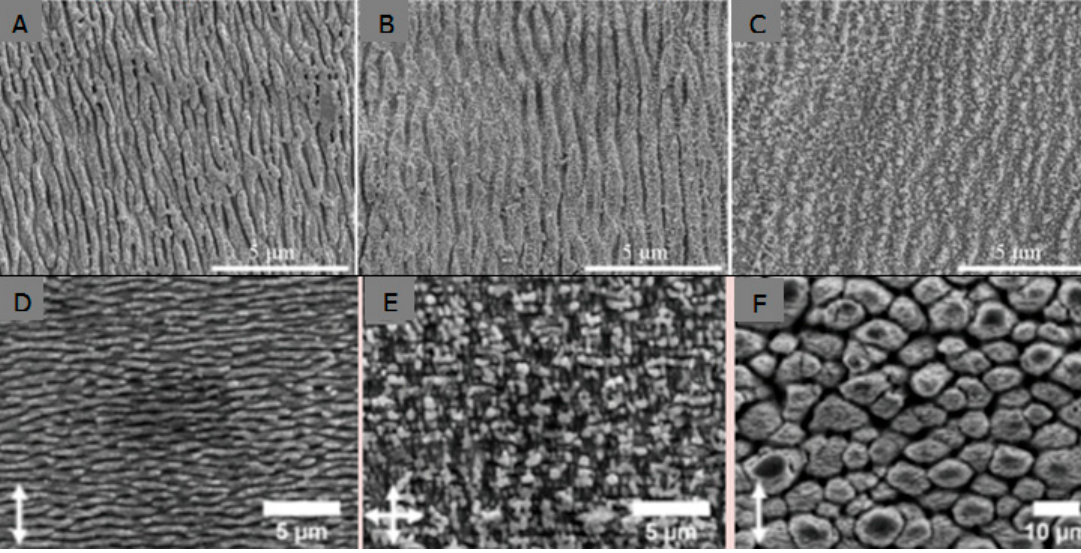
Figure 10. SEM micrographs of laser-induced periodic ripples surface structures ( A – D ), nanopillar ( E ) and microcolumn ( F ) textured surfaces [78,79]. Reprinted with permission from reference [78] 2015 Elsevier.